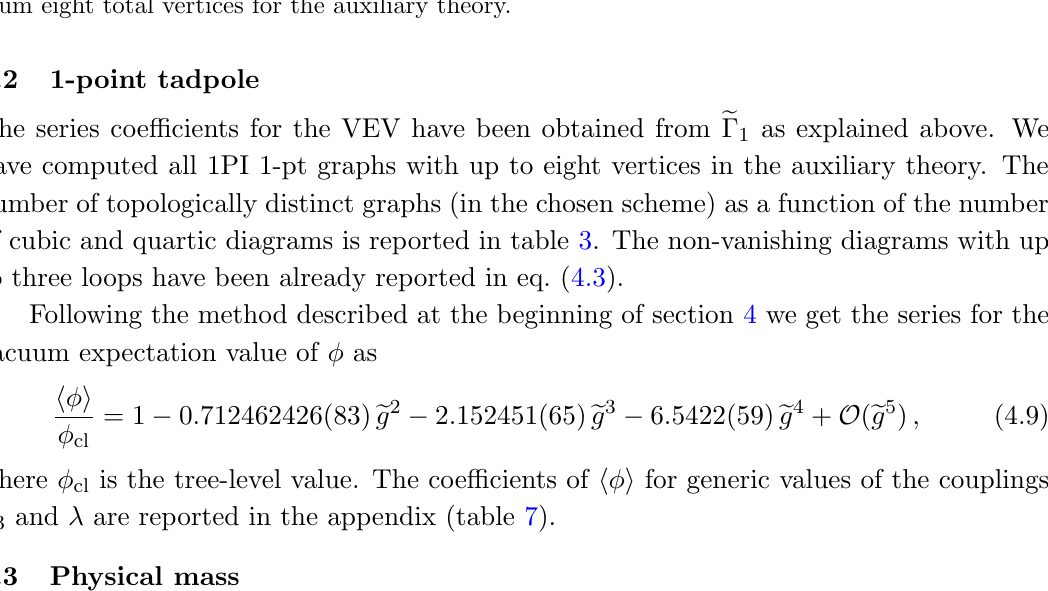
Table 3 . Number of topologically distinct 1PI 1-pt diagrams without self-contractions with maxi- mum eight total vertices for the auxiliary